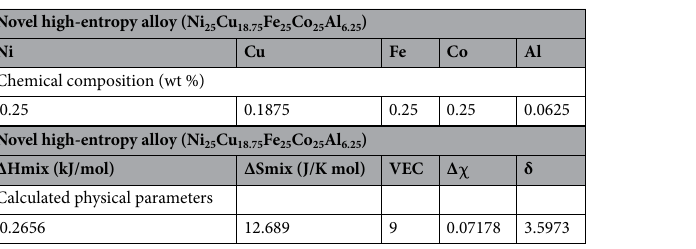
Table 3. Detailed description of newly synthesized high-entropy